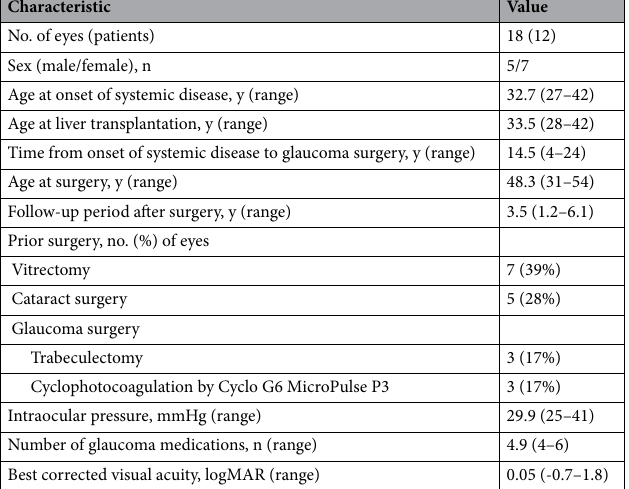
Number of glaucoma medications, n (range) Best corrected visual acuity, logMAR Table 1. Baseline demographic and clinical characteristics of patients with hereditary transthyretin amyloidosis with the Val30Met mutation. logMAR logarithm of the minimum angle of resolution.